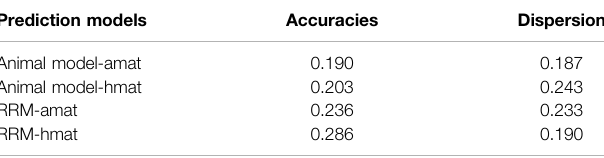
Animal Model-Amat: the animal model with A matrix; Animal Model-Hmat: the animal model with H matrix; RRM-Amat: random regression model with A matrix; RRM-Hmat: random regression model with H